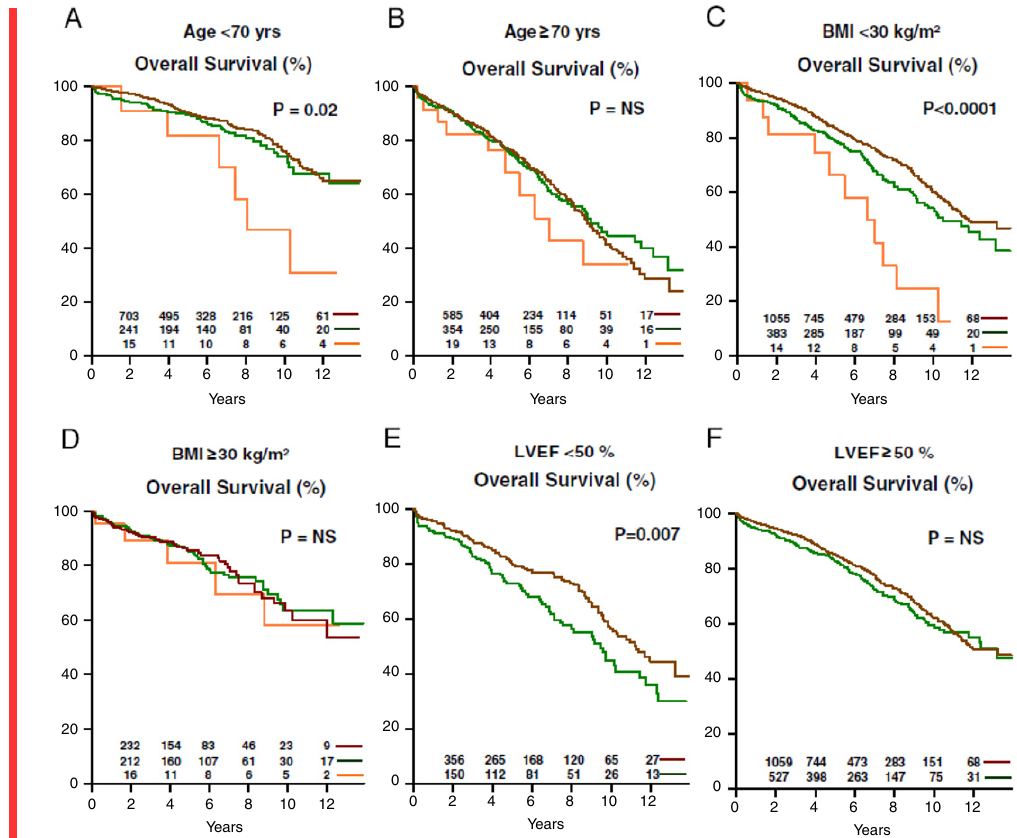
Figure. 9 Impact of prosthesis patient mismatch (PPM) on late overall survival. Panel A: Patients < 70 years old; Panel B: ≥ 70 years old; Panel C: body mass index < 30 kg/m 2 ; Panel D: body mass index ≥ 30 kg/m 2 ; Panel E: preoperative LVEF < 50%; Panel F: LVEF > 50%. Dark brown line: non-significant PPM; dark green line: moderate PPM in Panels A,B,C,D and moderate-severe PPM in Panels E and F; orange line: severe PPM. (Reproduced and modified with permission from [28]).